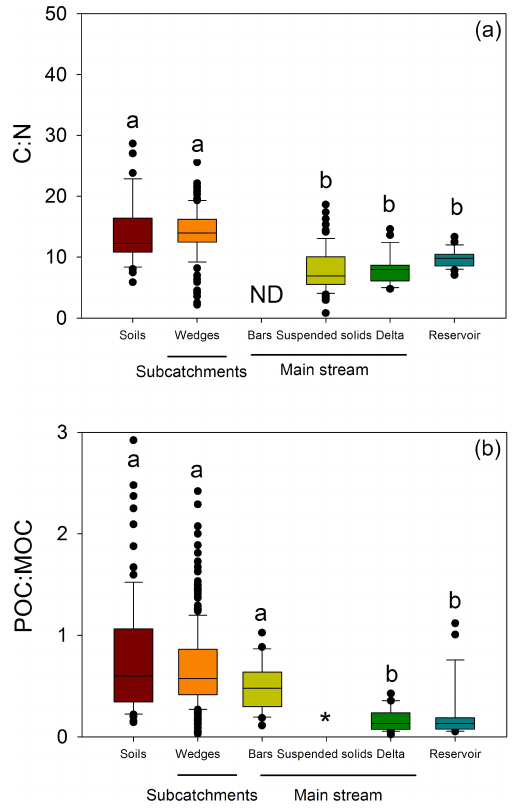
Figure 5. Median, percentiles (10th, 25th, 75th and 90th) and error of C:N ratios (A) and POC:MOC (B) ratios in soils and sediments within the Turrilla catchment. Different letters (a–b) indicate signif- icant differences according to the Kruskal–Wallis test ( p <